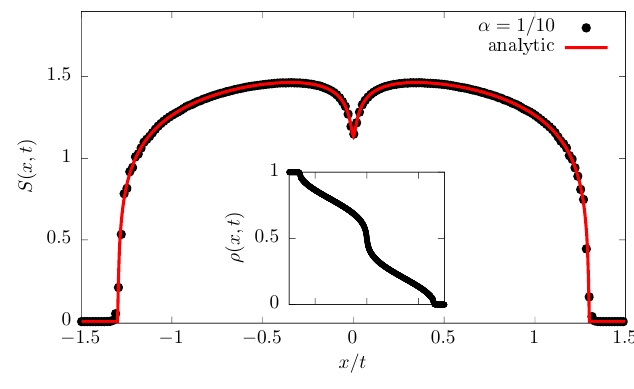
Figure 4: von Neumann entanglement entropy as a function of x / t after a quench from the domain wall initial state, for dispersion relation (cid:34) ( k ) = − cos k + α cos3 k and α = 1 / 10. he numerical simulations are performed using a finite system with 4096 sites. Data for t = 512 are reported (black circles) and compared to our analytical prediction (red lines): the agreement is nearly perfect. Inset: corresponding density profile ρ ( x , t ) after the